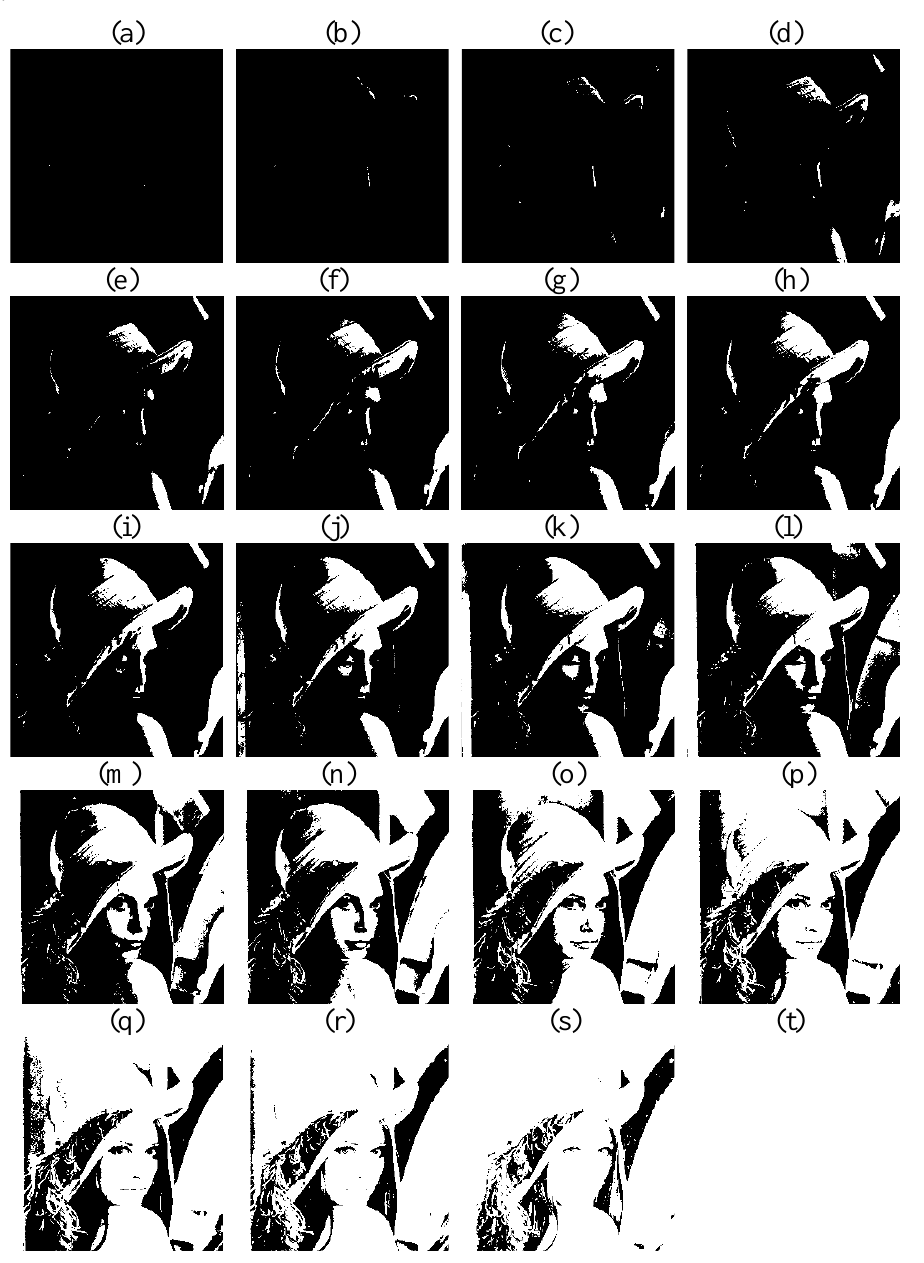
Figure 3. s [ n ] of each step of PCNN on Lena. (a) Step 1. (b) Step 2. (c) Step 3. (d) Step 4. (e) Step 5. (f) Step 6. (g) Step 7. (h) Step 8. (i) Step 9. (j) Step 10. (k) Step 11. (l) Step 12. (m) Step 13. (n) Step 14. (o) Step 15. (p) Step 16. (q) Step 17. (r) Step 18. (s) Step 19. (t) Step